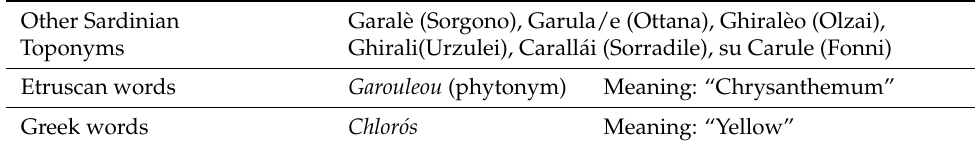
Table 2. Words linked to ‘Cagliari’ (Pittau 2018).